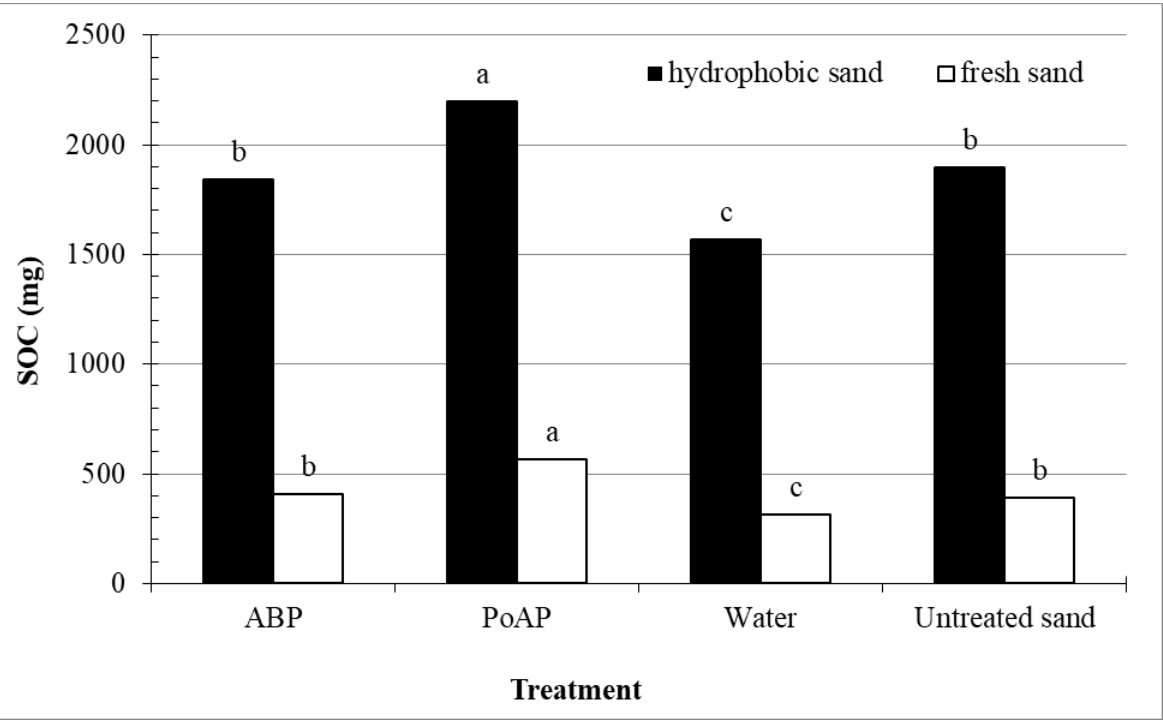
Figure 3. Solid phase organic carbon (SOC) of hydrophobic or fresh sand columns receiving three sequential treatment applications and following washes. Treatments included an alkyl block polymer (ABP), a polyoxyalkylene polymer (PoAP), and water, in addition to an untreated control (untreated sand). Bars labeled with the same letter for each sand were not significantly different based on Fisher’s Protected LSD at p < 0.05.